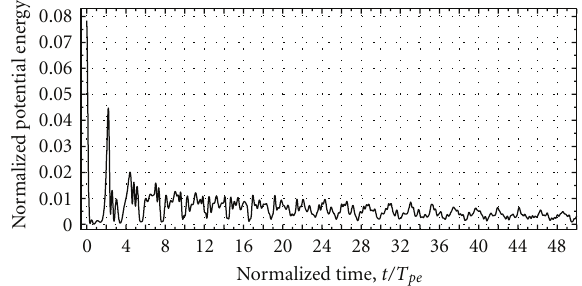
Figure 5: The time variation of the normalized potential energy of the plasma filling up all simulation region, W pot ( t ) /W 0 were obtained for the second situation when the initially created irregularity was studied. The normalized time, t/T pe , that is, the time in units of the equilibrium period of Langmuir oscillations of electrons, T pe , is shown on the